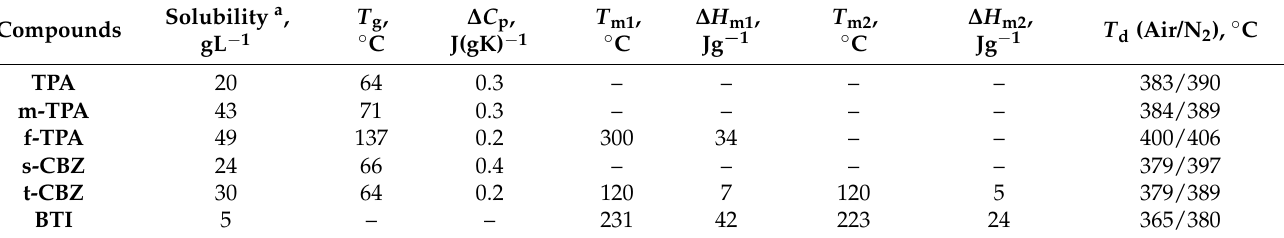
Table 1. Solubility, thermal data and phase behavior of oligomers.